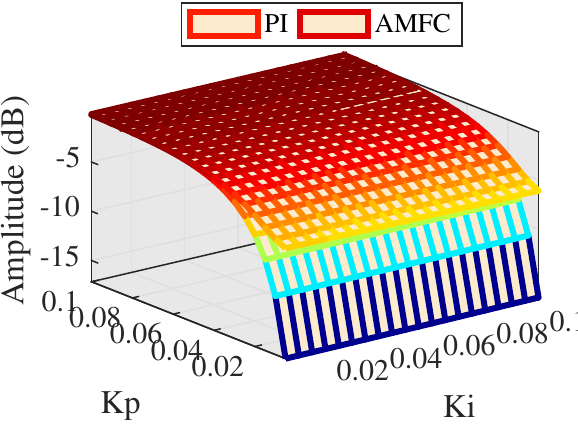
Figure 9. Amplitude comparison between PI and AMFC α =